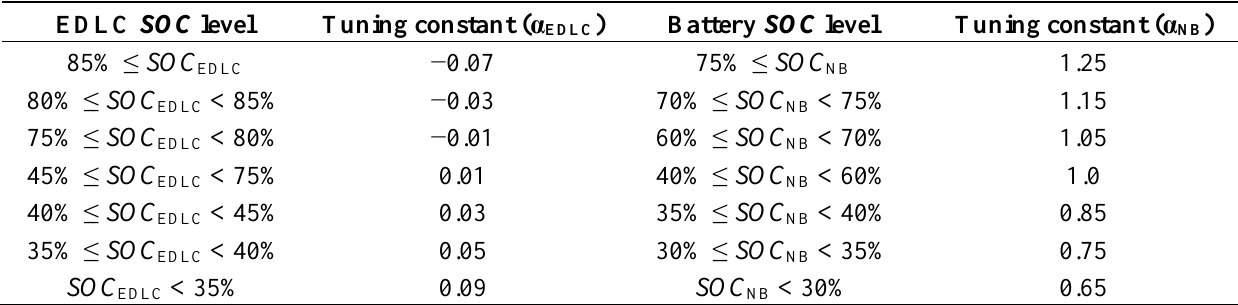
Table 2. Tuning constant for the SOC control of EDLC and Ni-MH battery